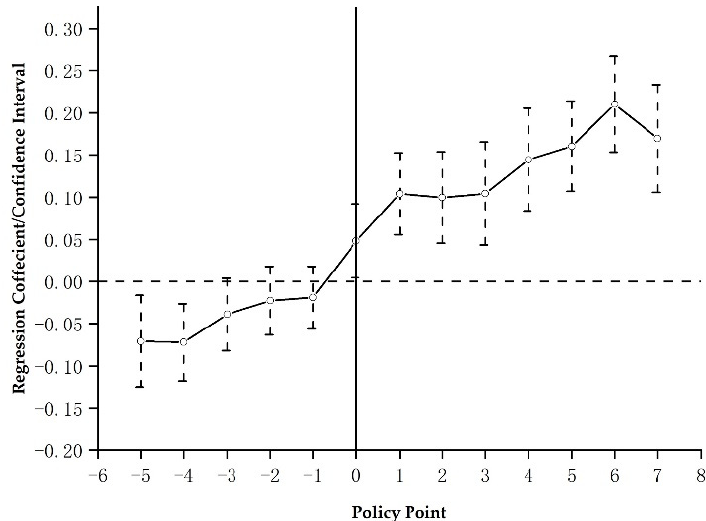
Figure 3. Temporal heterogeneity of the pilot low-carbon city policy effect.